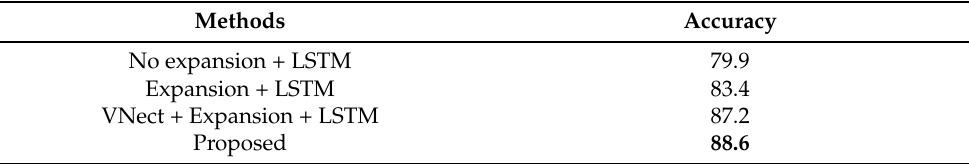
Table 4. Experimental results with the NW-UCLA dataset.